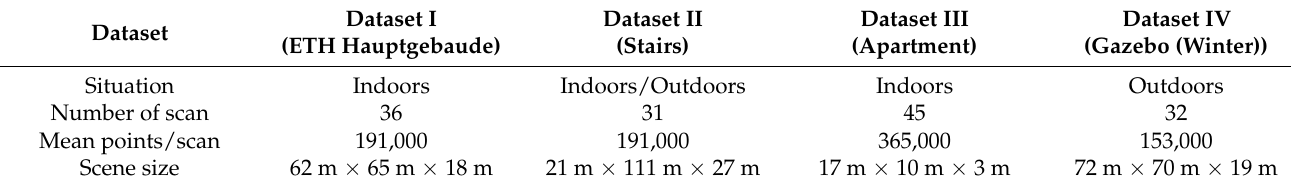
Table 1. Properties of the four